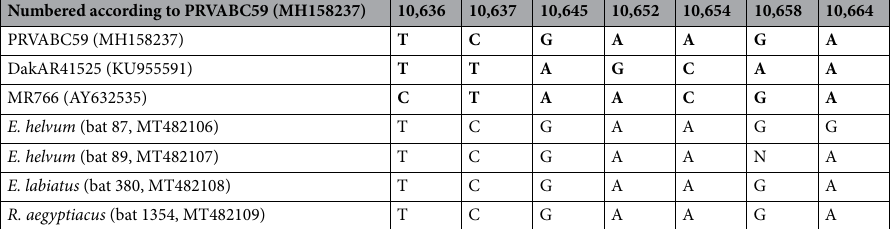
Numbered according to PRVABC59